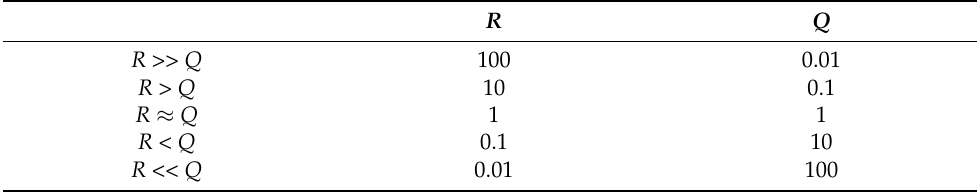
Table 3. The assignment of R and Q